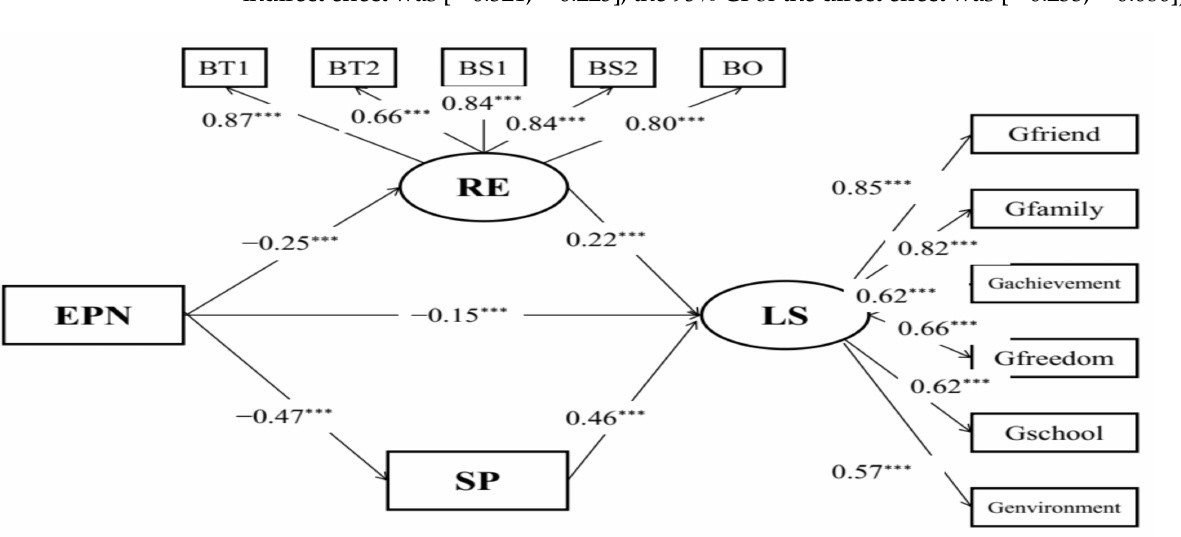
95% CI of the indirect effect was [ − 0.371, − 0.275]; the 95% CI of the direct effect was [ − 0.220, −